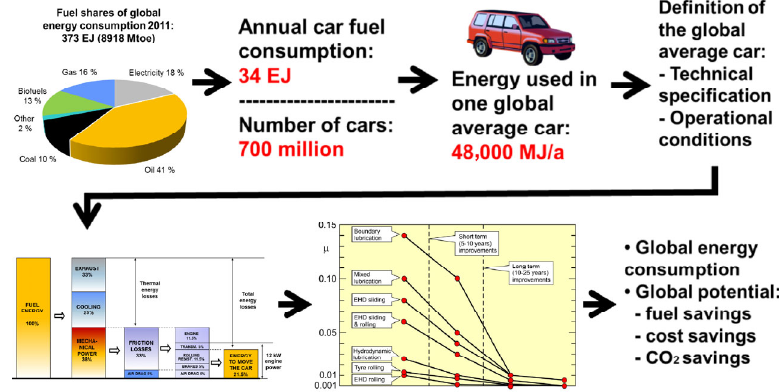
Fig. 2 Methodology for calculating global impact of friction on fuel consumption in passenger cars and potential savings